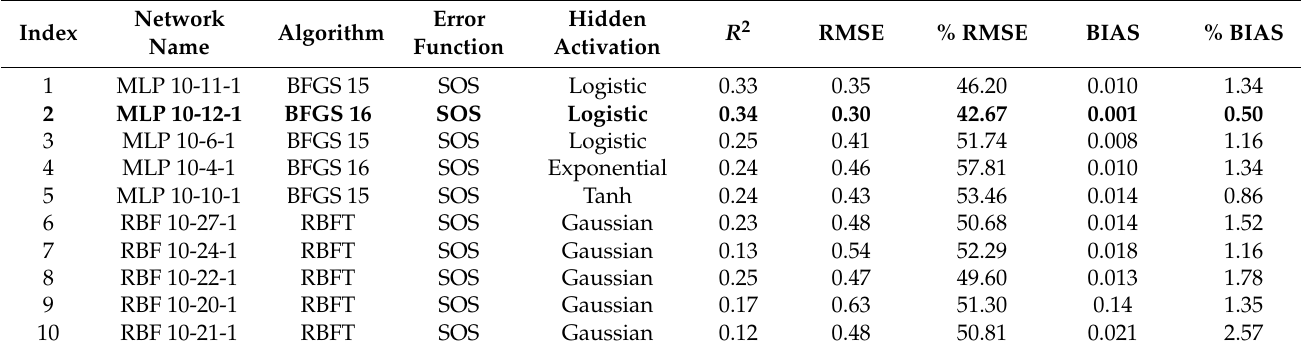
Table 6. Characteristics of RBF and MLP-based ANNs and associated metrics for productivity model evaluation.